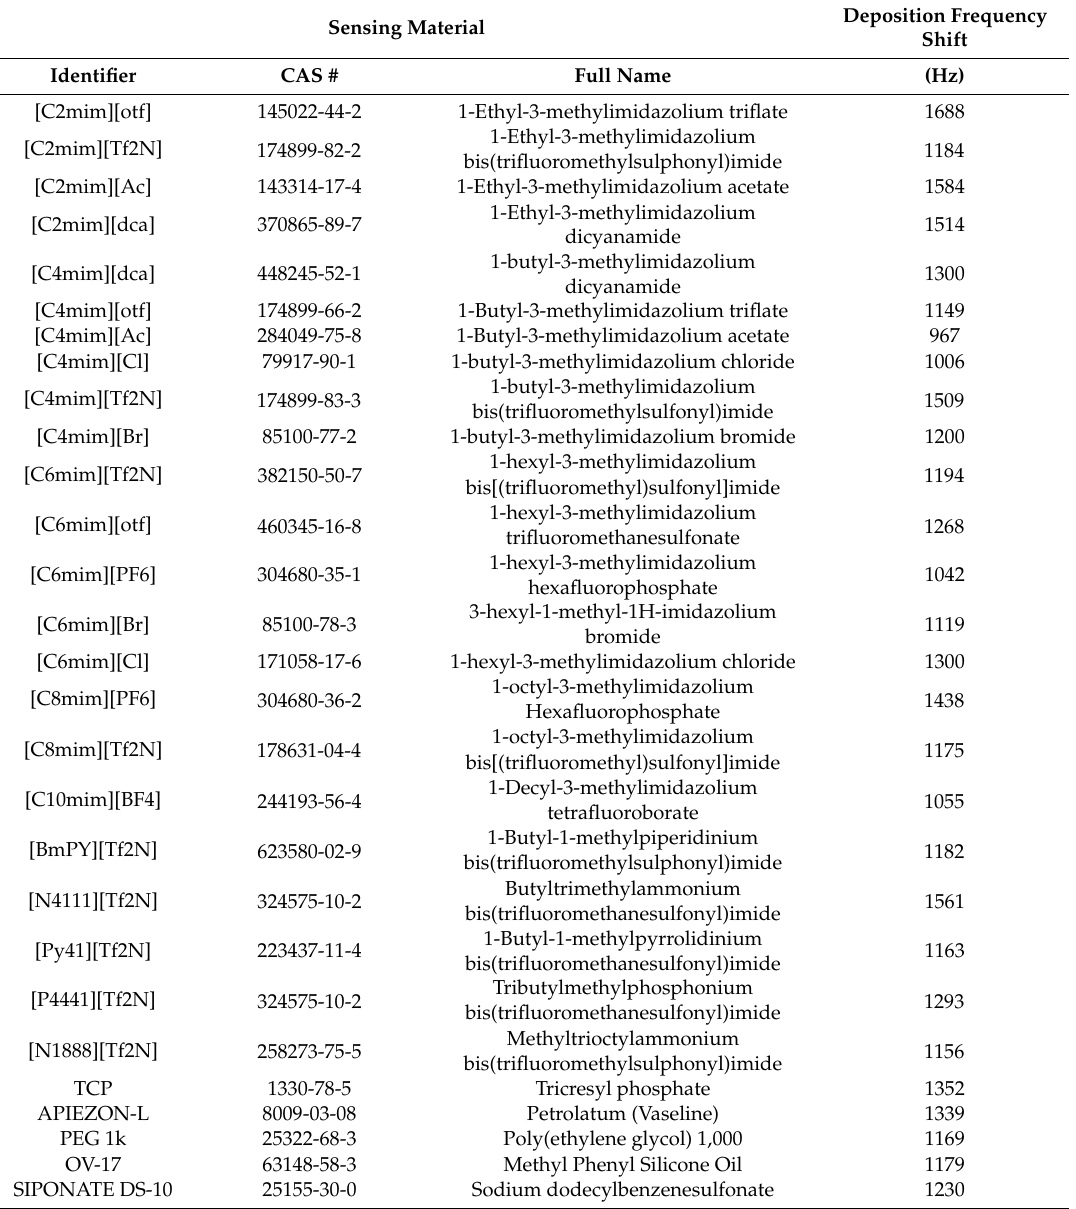
Table 1. Details of the sensing materials used in the study and the quartz crystal microbalance (QCM) frequency shift of the sensing layer